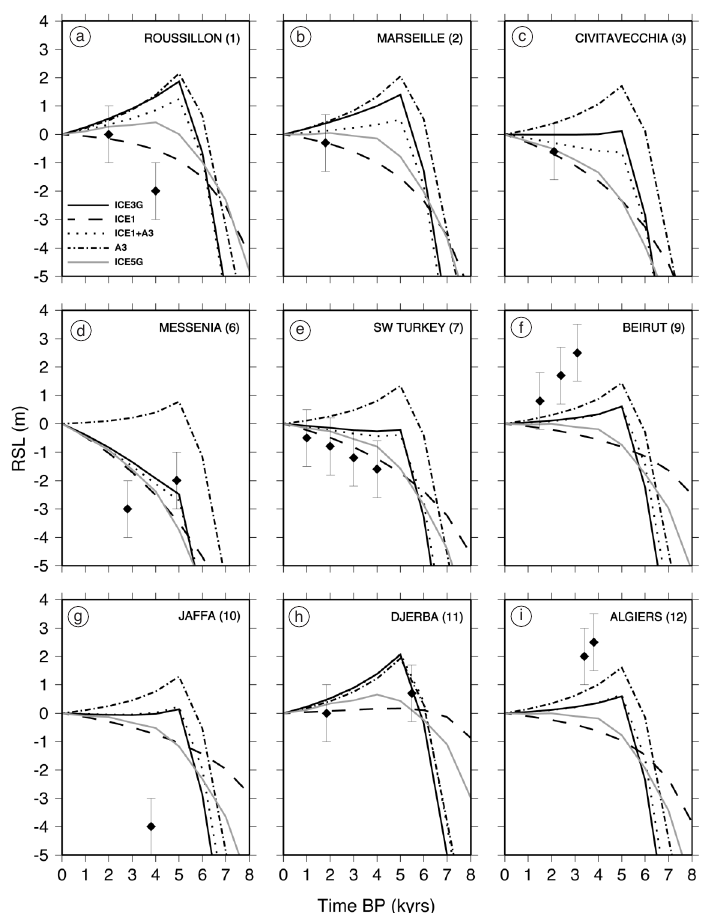
Fig. 4a-i. Observed and synthetic RSL for some of the sites of fig. 3a. Predictions are obtained by VM1 and models ICE3G, ICE1+A3, ICE1, A3, and ICE5G. RSL data and error bars are taken from the TP database with the exception of Djerba (Jedoui et al. , 1998). Since the TP RSL indicators are not calibrated, this comparison has mainly a qualitative character. In Djerba the melting of Antarctica provides virtually the whole signal dur- ing the last 6 kyrs (compare solid with dash-dotted curve in frame